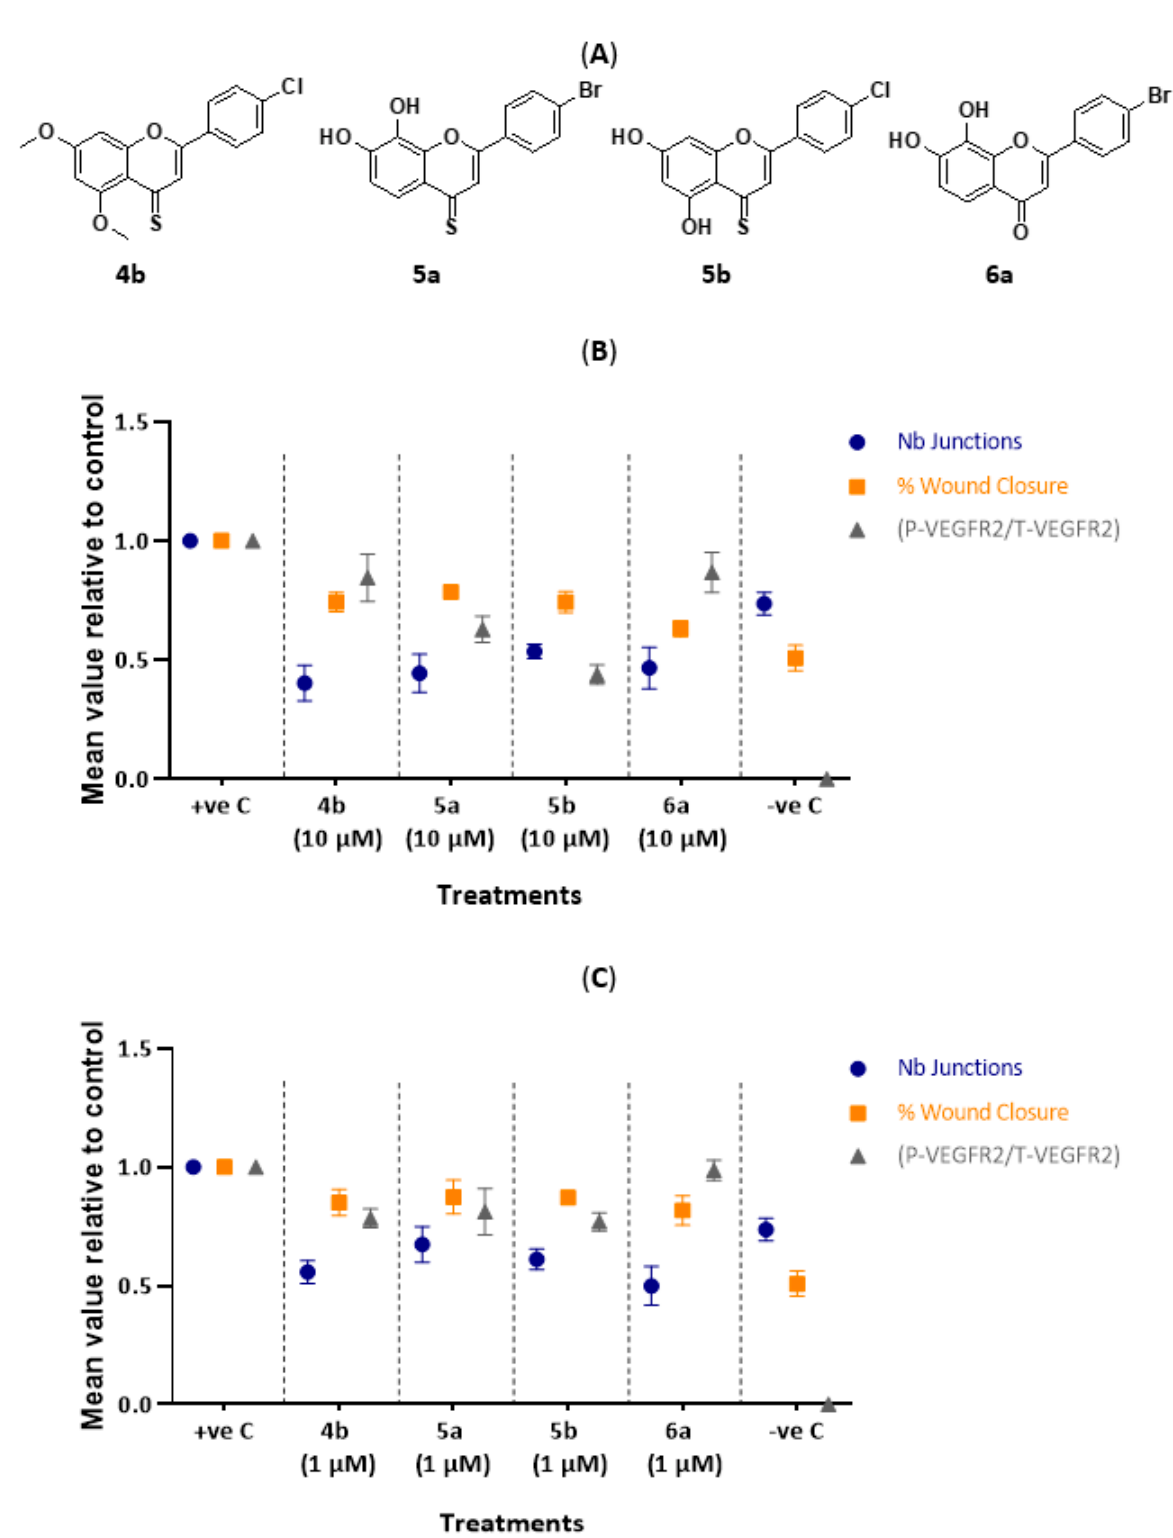
Figure 6. Comparison between tube formation (represented by nb junctions), scratch and Western blotting assay results of flavonoid derivatives ( 4b , 5a , b and 6a ). ( A ) Chemical structures of 4a , 5a , b and 6a ; ( B ) comparison of 10 µM concentration; ( C ) comparison of 1 µM concentration.